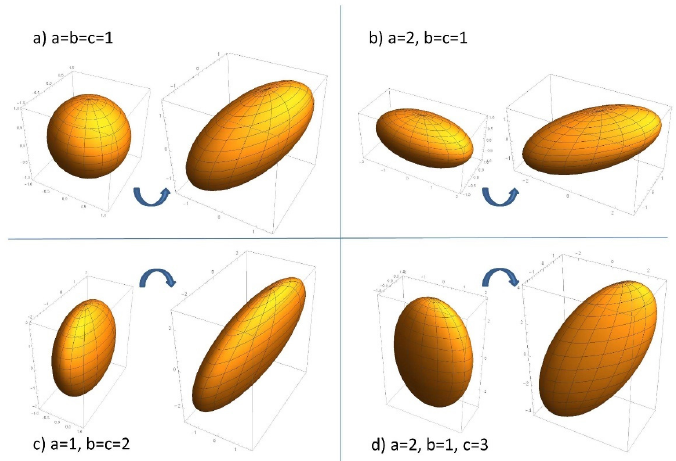
√ 3. Legends in the panels indicate